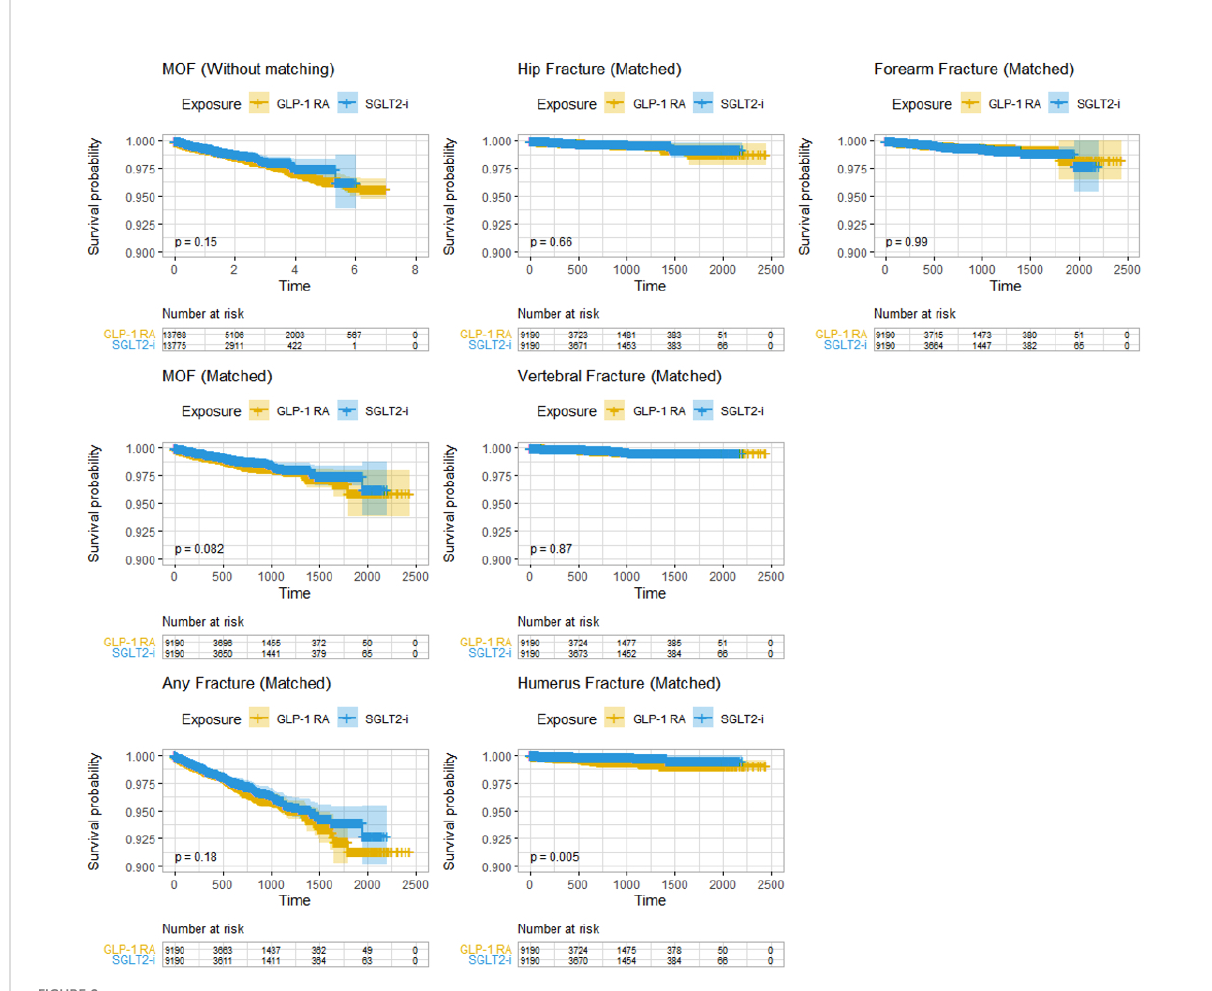
FIGURE 2 Kaplan-Meier Survival Curves of fracture. Survival curves are presented with number-at-risk tables. Time in days on the x-axes. Note, the y-axes go from 0.90 to 1.00. MOF, Major osteoporotic fracture; GLP-1 RA, Glucagon-like peptide-1 receptor agonists; SGLT2-i, sodium-glucose cotransporter 2